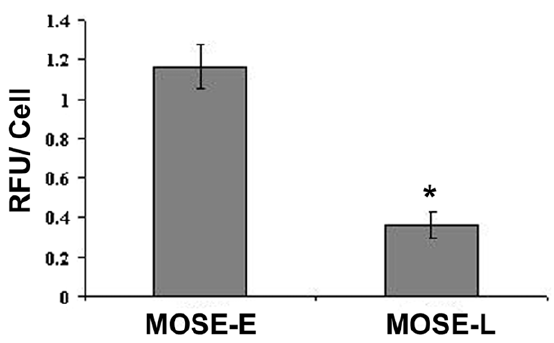
Figure 4. Quantitation of filamentous actin in pre-malignant and malignant MOSE cells. Equal numbers of MOSE-E or MOSE-L cells where plated. After 48 hours, cells were fixed with paraformalde- hyde and stained with phalloidin conjugated with Alexa Fluor 488 . The phalloidin was solubilized with MeOH and fluorescence was deter- mined. Data were normalized to cell number and presented as the mean relative fluorescent units (RFU) per cell 6 the standard deviation. * p #